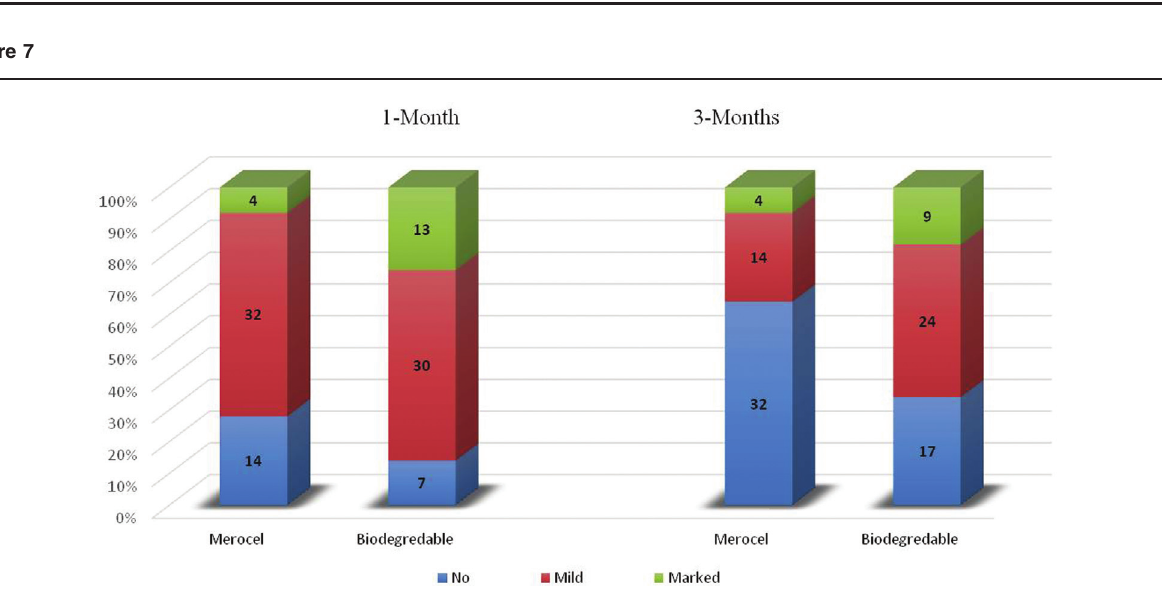
Bar chart illustrating mucosal edema at 1- and 3-month postoperatively.